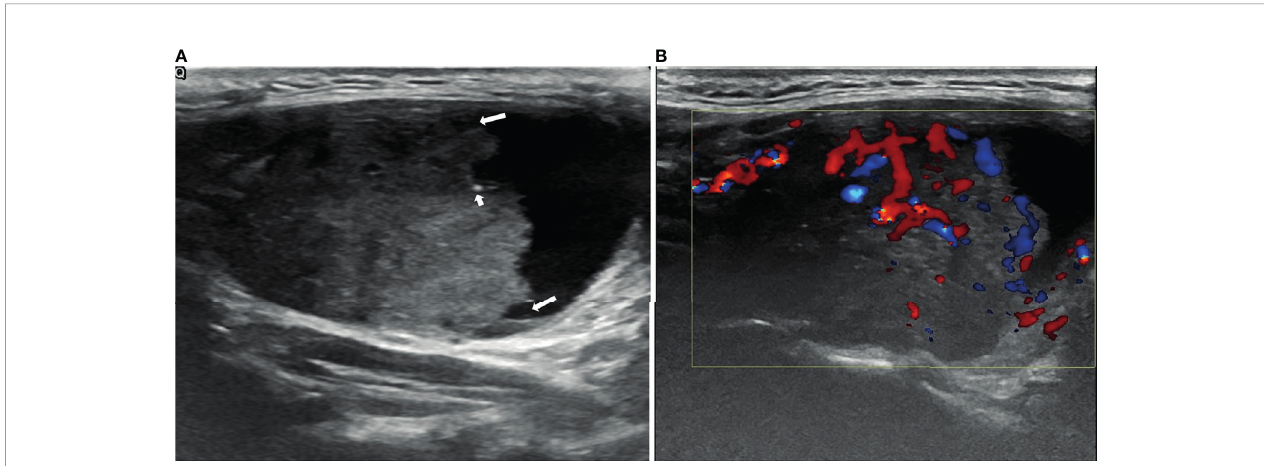
FIGURE 1 | An example of a PCTN with an eccentric solid position with an acute angle (long arrows) in a 38-year-old woman. Longitudinal ultrasound (US) image of a 5.06×3.07cm nodule with internal solid composition (accounted for approximately 64% of the total PCTN volume.) showing ill-de fi ned margin and a little micro- calci fi cation (short arrows) (A) . CDFI showing internal and peripheral fl ow inside the solid component (B) . Papillary thyroid carcinoma was diagnosed by fi ne needle aspiration (FNA) and con fi rmed by surgical